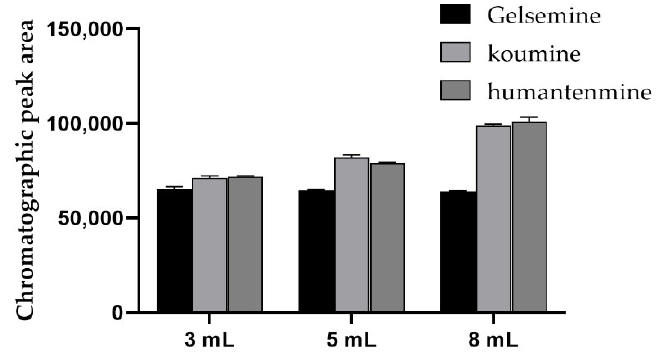
Figure 3. Comparison of elution effects with 3 mL, 5 mL and 8 mL of elution solvent.